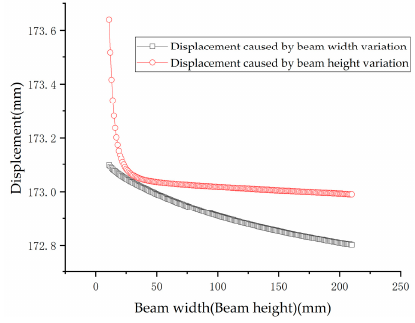
Figure 5. Sensitivity curve of B M height and width.